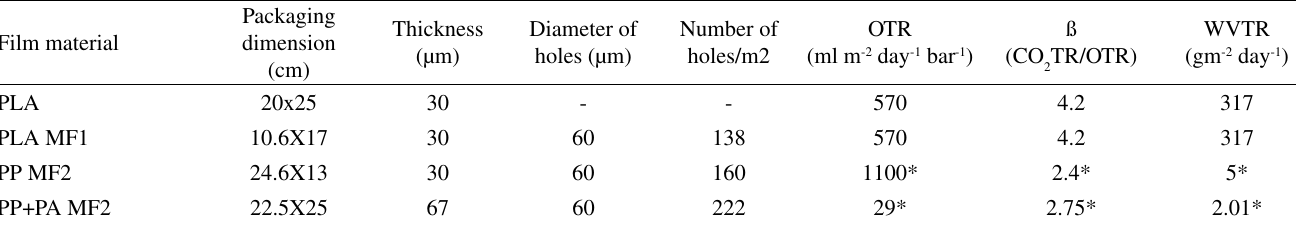
Table 1 - Film material and packaging characteristics Film